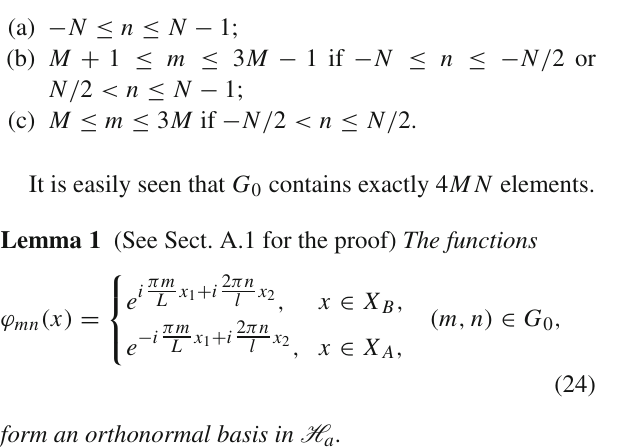
(cid:4) (cid:4) } , H t } = sf { D (cid:3) t